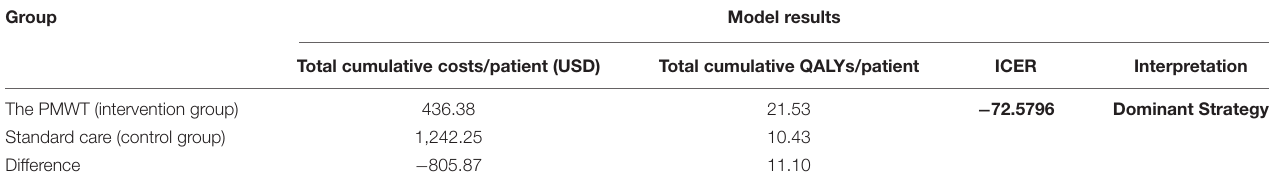
TABLE 5 | Decision analytic model results.